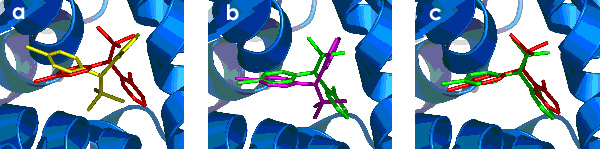
Comparison of ligand conformation prediction for o,p-DDT docked to hERα. Panel a. Best scored solutions with AutoDock. Calculated binding energies were -31.1 kJ/mol for solution 1 (red) and -30.8 kJ/mol for solution 2 (yellow). Panel b. Corresponding refinement with QXP: assigned total binding energies were -22.2 kJ/mol for pose 1 (green) and -15.5 kJ/mol for pose 2 (violet). Panel c. Structural superposition of pose 1 from AutoDock and pose 1 from QXP (RMSD = 0.087 Å).